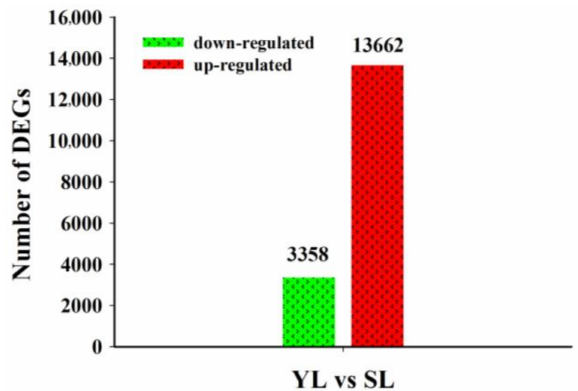
Figure 2. Number of differentially expressed unigenes during leaf senescence identified by RNA-Seq data in Lonicera macranthoides . Differentially expressed unigenes (DEGs) between young and senescing leaves were illustrated by bar chart. Red and green bars represent the up-regulated and down-regulated unigenes in senescing leaves (SL) compared with those in young leaves (YL), respectively in Lonicera macranthoides